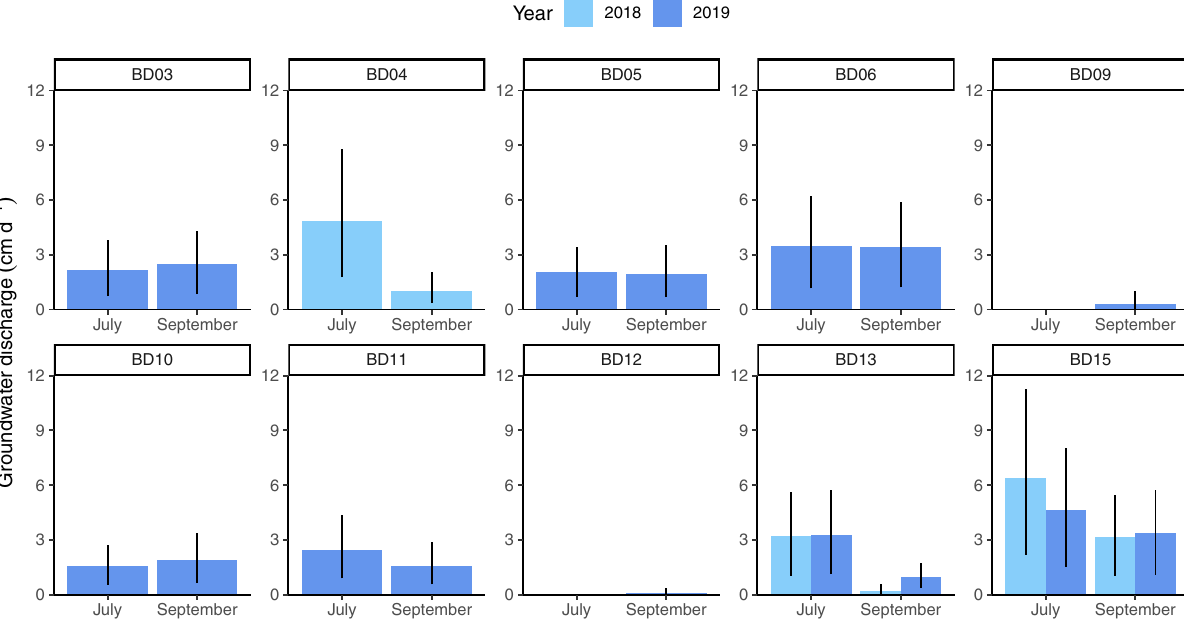
Fig. 2 222 Rn-derived groundwater in fl ows into the study lakes. Values and error bars are obtained from the median and the 25th and 75th percentiles, respectively, of the 1000 Monte Carlo simulations for each lake and